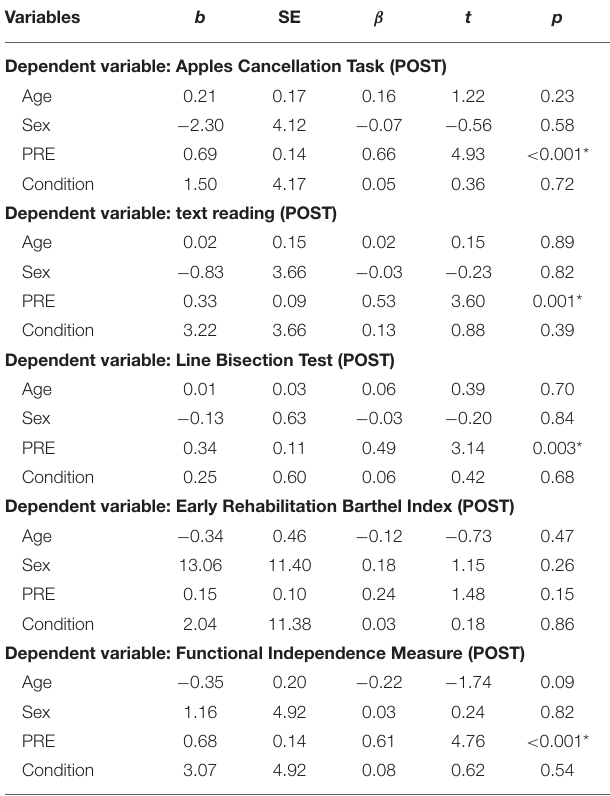
TABLE 3 | Ordinal linear regression models examining post-treatment neuropsychological test results ( N = 40). Variables